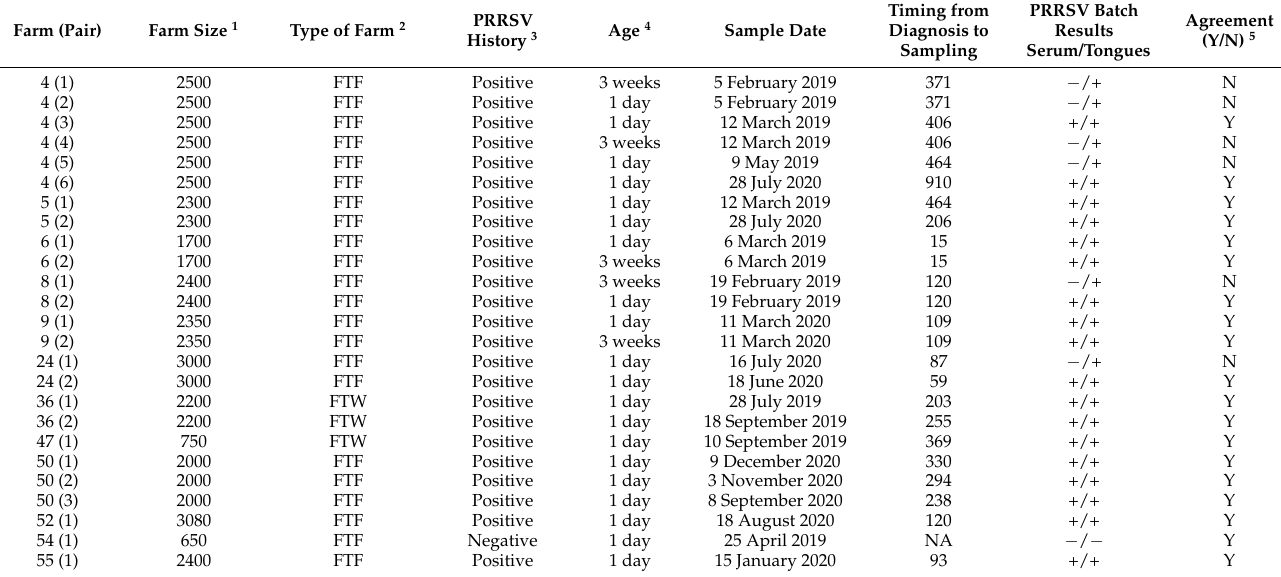
Table 1. Sow farm and sample characteristics to study the agreement between paired serum and tongue samples (between brackets) for Porcine Reproductive and Respiratory Syndrome virus (PRRSV) diagnosis in a production batch.